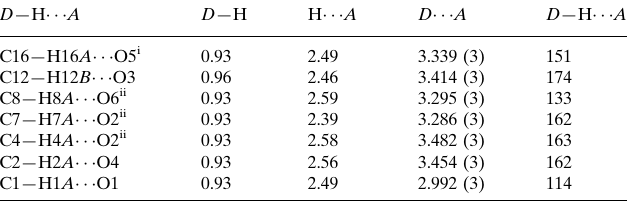
Hydrogen-bond geometry (A˚ , (cid:2)